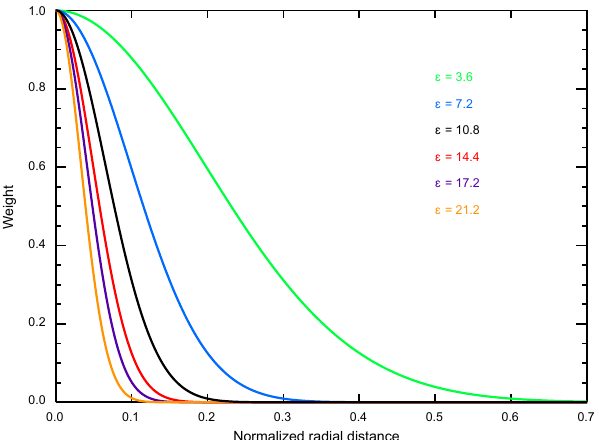
Figure 1. Weight assigned to each node point as a function of radial distance in normalized parameter space. The decay is isometric in the parameter space and the same for all node